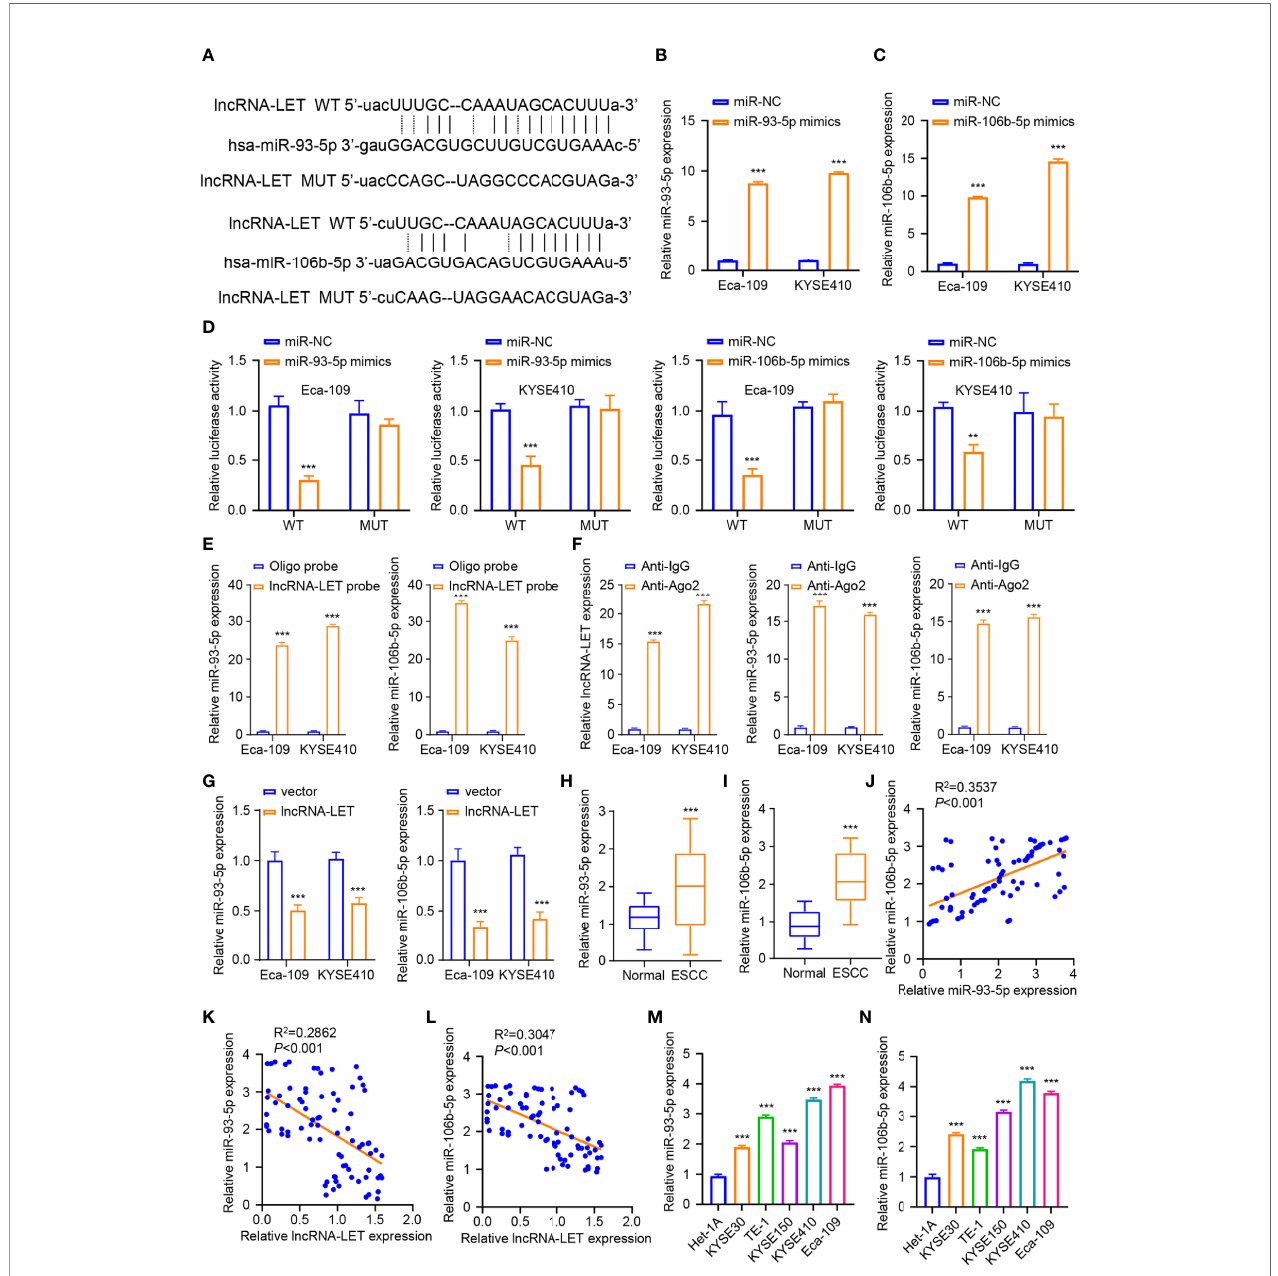
FIGURE 3 | (A) The binding sites for miR-106b-5p and miR-93-5p predicted on lncRNA-LET were checked by starBase database. We conducted qRT-PCR to measure the (B) miR-93-5p levels after miR-nc mimic or miR-93-5p mimic transfection. (C) The miR-106b-5p level with miR-93-5p mimic or miR-nc mimic transfection. (D) Wild-type lncRNA-LET plasmid or binding site mutant plasmid luciferase activity affected by miR-106b-5p or miR-93-5p mimic transfection was detected by dual-luciferase activities. (E) The interaction of lncRNA-LET and with miR-93-5p/miR-106b-5p was veri fi ed through RNA pull-down assay. (F) The enrichment of lncRNA-LET, miR-93-5p, and miR-106b-5p was performed through RNA immunoprecipitation – qRT-PCR. (G) The miR-93-5p and miR-106b-5p levels within Eca-109 and KYSE410 cells after lncRNA-LET transfection were measured through qRT-PCR. We conducted qRT-PCR for detecting (H, I) miR-106b-5p and miR-93-5p expression within clinical tissue samples. (L) The miR-93-5p level and (M) miR-106b-5p level within esophageal squamous cell carcinoma (ESCC) cell and healthy esophageal epithelial cell line het-1a. (J) The correlation between the relative expressions of miR-106b-5p and miR-93-5p in the patient samples. (K,